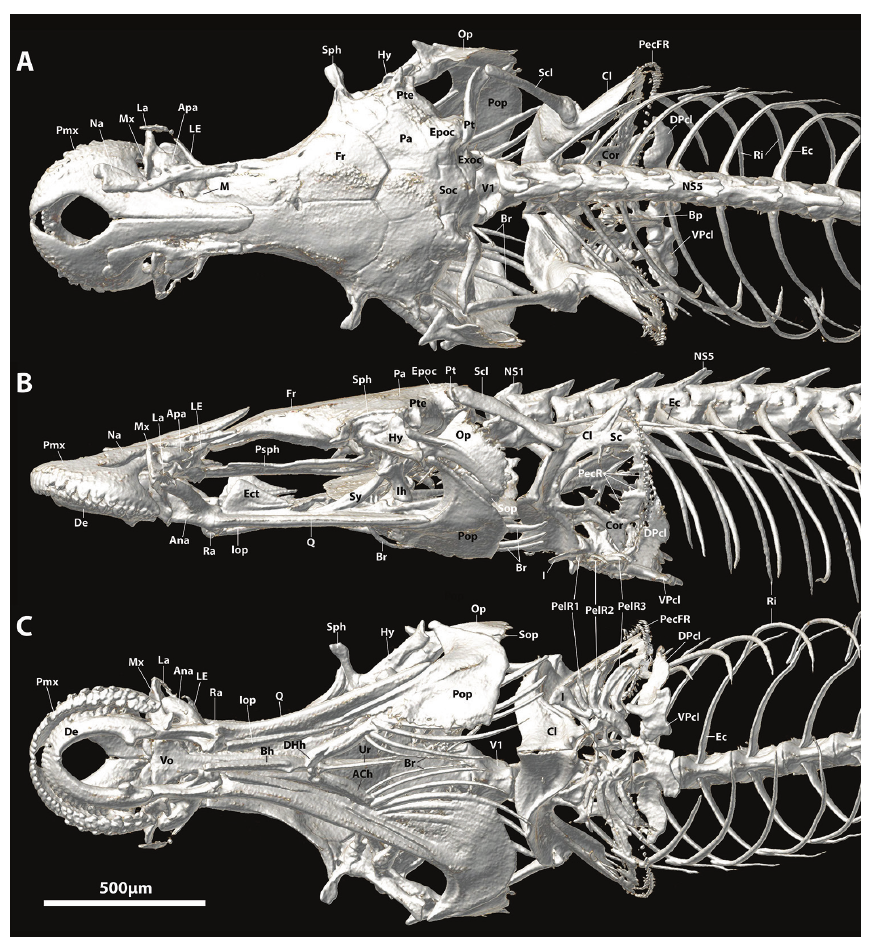
Figure 17. CT scanned anterior skeleton of Lepadichthys bolini , ROM 55185, 21.5 mm SL. A Dorsal view B Lateral view (left side) C Ventral view. Abbreviations: ACh, anterior ceratohyal; Ana, anguloarticu- lar; Apa, autopalatine; Bp, basipterygium; Br, branchiostegal rays; Cb5, ceratobranchial 5; Cl, cleithrum; Cor, coracoid; DHh, dorsal hypohyal; DPcl, dorsal postcleithrum; Ec, epicentral; Ect, ectopterygoid; Epoc, epiotic; Exoc, exoccipital; Fr, frontal; Hy, hyomandibular; I, pelvic-fin spine; Iop, interopercle; La, lachrymal; LE, lateral ethmoid; M, mesethmoid; Na, nasal; NS1, 5, neural spine of vertebral centrum 1, 5; Op, opercle; Pa, parietal; PecR, pectoral radial; PecFR, pectoral-fin ray; PelFR1-4, pelvic-fin ray 1–4; Pop, preopercle; Pro, prootic; Psph, parasphenoid; Pt, posttemporal; Pte, pterotic; Q, quadrate; Ra, ret- roarticular; Ri, rib; Sc, scapula; Scl, supracleithrum; Soc, supraoccipital; Sop, subopercle; Sph, sphenotic; Ur, urohyal; V1, vertebral centrum 1; Vo, vomer; VPcl, ventral